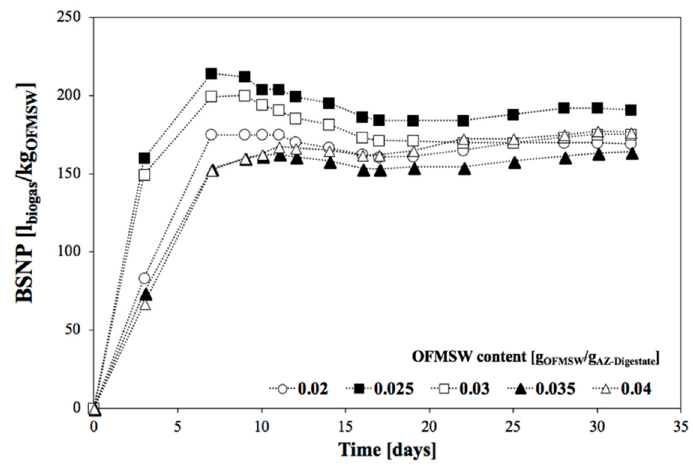
Figure 6. Biogas specific net productivity as a function of reaction digestion time during batch wet- AD of agro-zootechnical (AZ) digestate containing a different tenor of OFMSW.